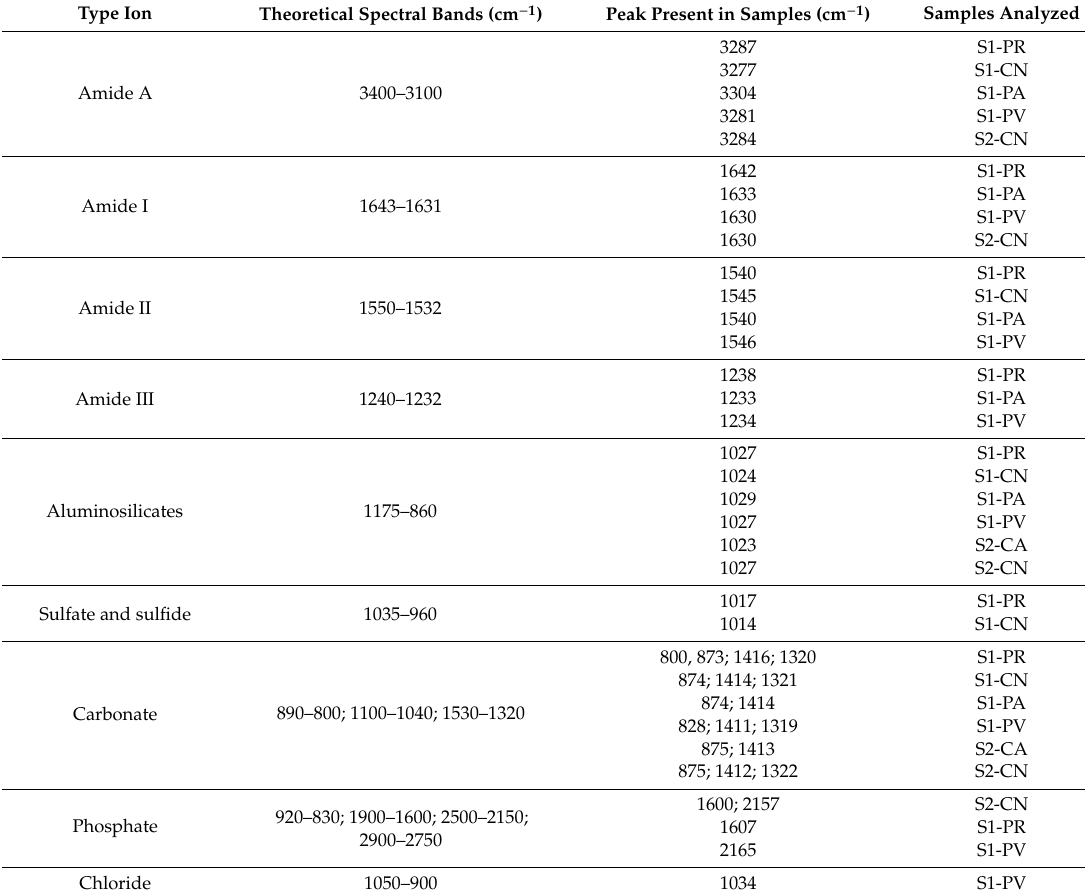
Table 2. Representative peaks and spectral bands of the ions identified in the samples analyzed by